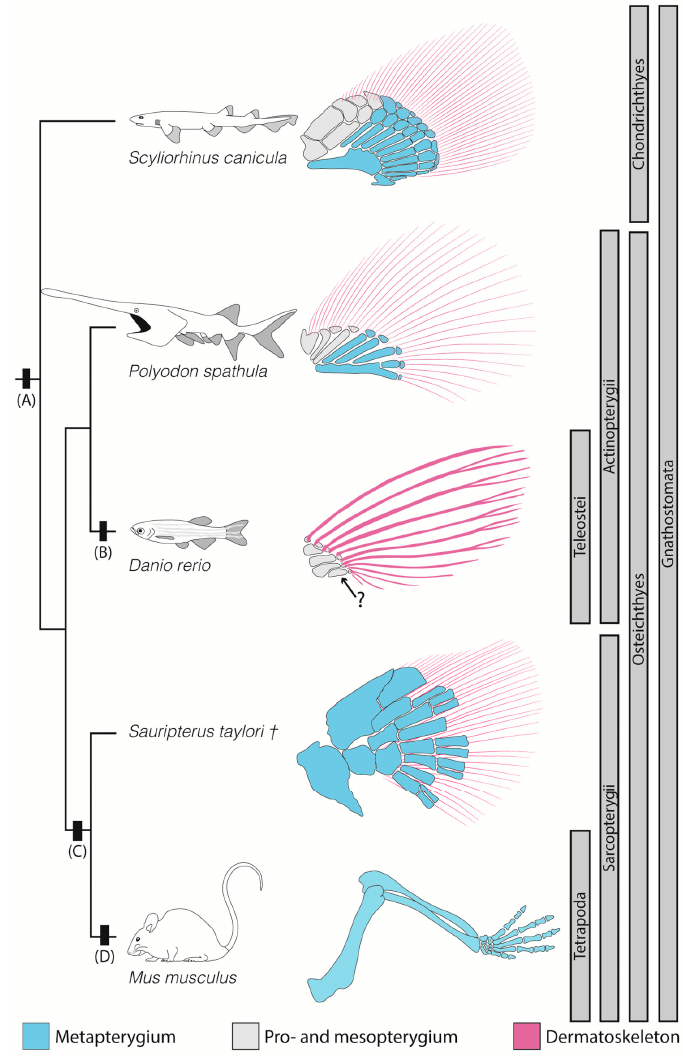
Figure 2. Patterns of anatomical loss and gain define paired appendage evolution. ( A ) Paired ap- pendages are ancestral for gnathostomes, consisting of the pro- and mesopterygium (gray), metaptery- gium (blue), and fin rays (pink). This arrangement is conserved in catshark ( Scyliorhinus canicula ) and paddlefish ( Polyodon spathula ). ( B ) Teleosts (e.g., Danio rerio ) possess a reduced endoskeleton com- posed of pro- and mesopterygial elements. In teleosts, the metapterygium has been either completely lost or is greatly reduced (see area indicated by the “?”). ( C ) Sarcopterygians are characterized by the loss of the pro- and mesopterygium and expansion of the metapterygium. ( D ) Within tetrapods, the limb is proximo-distally regionalized, with a distinctive distal autopod and the loss of the fin rays. Only pectoral appendages are shown here for clarity. Illustrations not to